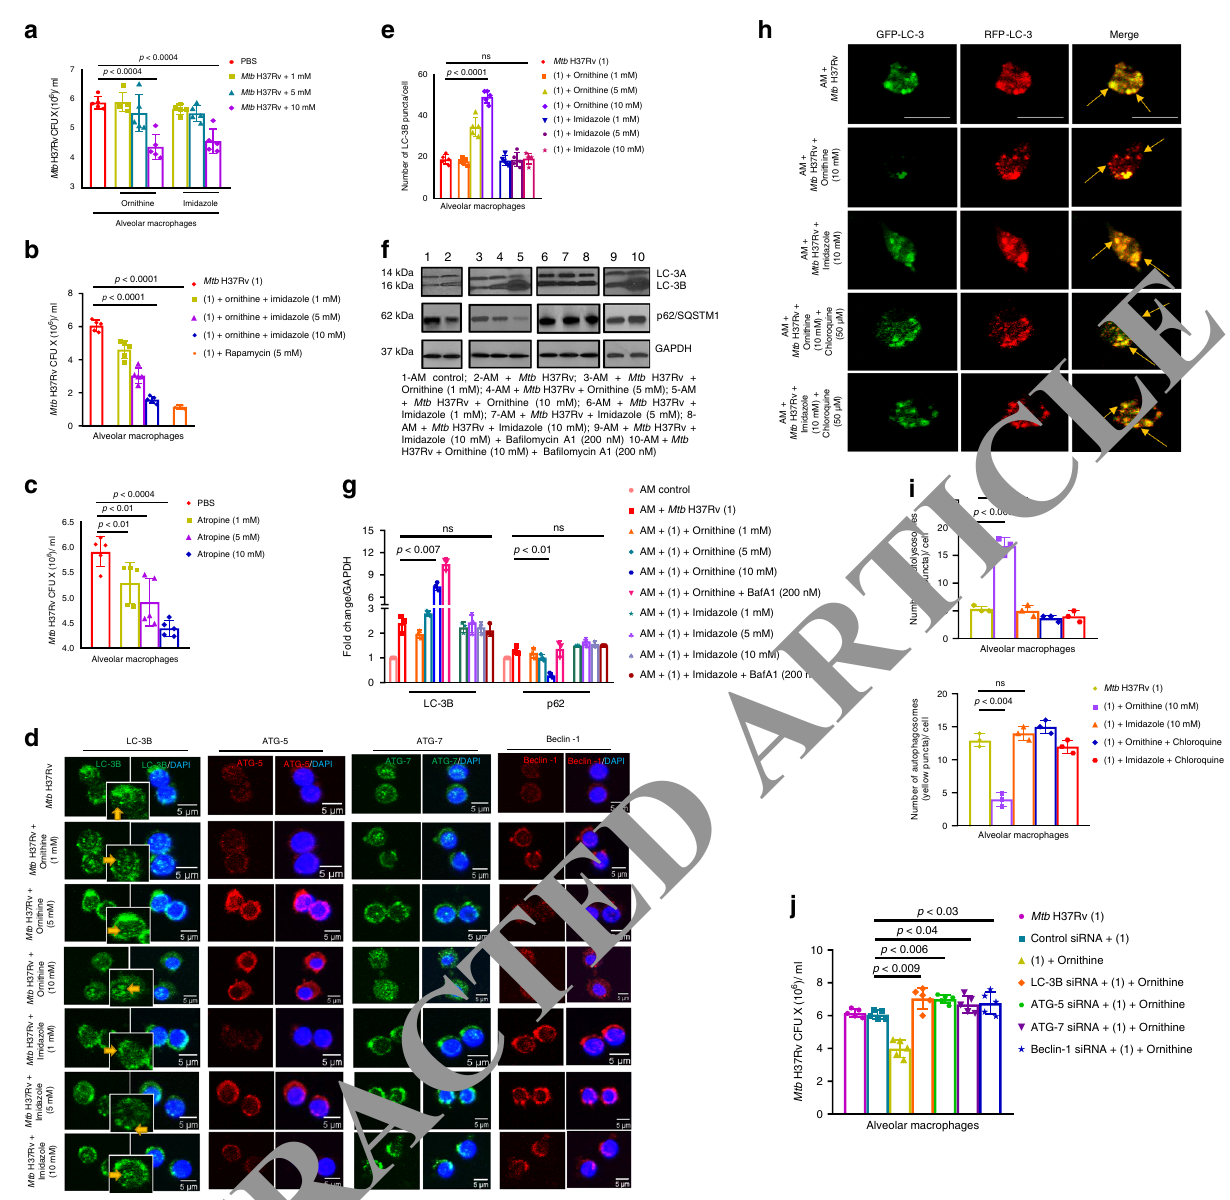
Fig. 5 Ornithine, imidazole and atropine affect Mtb growth. AMs were infected with Mtb H37Rv. At 2 h post-infection, ornithine and imidazole alone or in combination were added alongside atropine. Intracellular CFUs were demonstrated after 5 days post-infection. a Ornithine and imidazole alone, b in combination of both, c atropine. p < 0.0181, p < 0.0112. n = 5 experiments each. d A representative micrograph of LC3-B, ATG-7, ATG-5 and Beclin-1 in AMs and KCs. Blue: DAPI; green: LC-3B and ATG-7; red: ATG-5 and Beclin-1. Images of multiple fi elds at 63× magni fi cation were taken with oil immersion. e The number of LC-3B puncta relative to the cell area (10 cells per condition) was quanti fi ed using ImageJ. Data shown are representative of fi ve independent experiments. f Total protein was extracted and western blotting was performed. A representative blot depicting the levels of LC-3 and p62/ SQSTM1 in the control and Mtb -infected macrophages followed by treatment with ornithine and imidazole is shown. GAPDH was used as a loading control. g Normalized fold intensities of LC-3B and p62 levels in Mtb -infected and ornithine or imidazole treated macrophages compared with the levels in the uninfected control. p < 0.0072, p < 0.019, ns not signi fi cant. n = 3 experiments. h Alveolar macrophages were labeled with an autophagy sensor expressing RFP-GFP-LC3B for 48 h. Macrophages were then infected with Mtb followed by treatment with ornithine or imidazole for 72 h. Cells were fi xed, and LC-3 was analyzed by confocal microscopy. Scale bars: 5 µ m. i Quanti fi cation of the number of LC-3B positive autophagosomes (yellow fl uorescence) and autolysosomes (red fl uorescence) in control and Mtb -infected macrophages treated with ornithine and imidazole. p < 0.0041, p < 0.0034. n = 3 experiments. j AMs from C57BL/6 mice were isolated and transfected with the siRNAs targeting LC-3B, ATG-5, ATG-7 and Beclin-1 or with control siRNA, infected with Mtb and then treated with 10 mM ornithine. After 5 days, CFUs were counted. p < 0.0097, p < 0.0067, p < 0.046, p < 0.0327. n = 5 experiments. Data are presented as the mean ± SD using paired two-tailed t